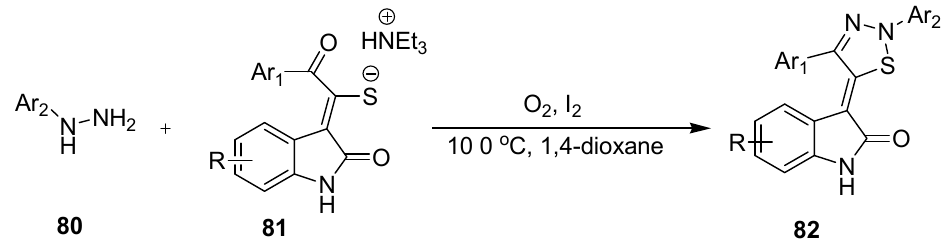
Scheme 17. I 2 /O 2 mediated synthesis of 1,2,3-thiadiazoles ( 82 ).